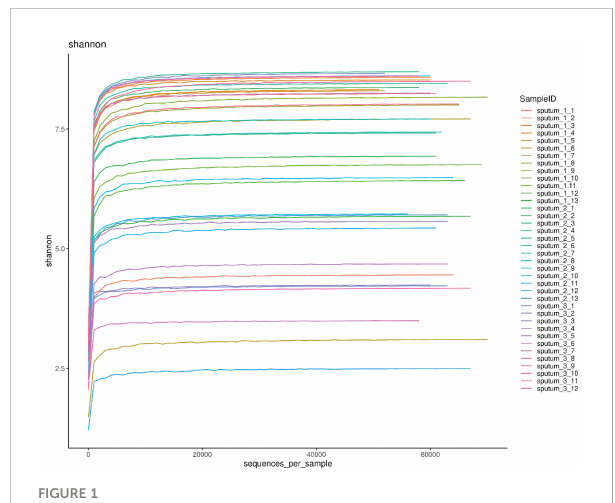
FIGURE 1 The rarefaction curve of 38 respiratory tract microbiota. Shannon- Wiener analysis of 38 respiratory samples. The x-coordinate is the number of sequences per sample, and the y-coordinate is the Shannon rarefaction measure. The higher the y value is, the higher the community a -diversity